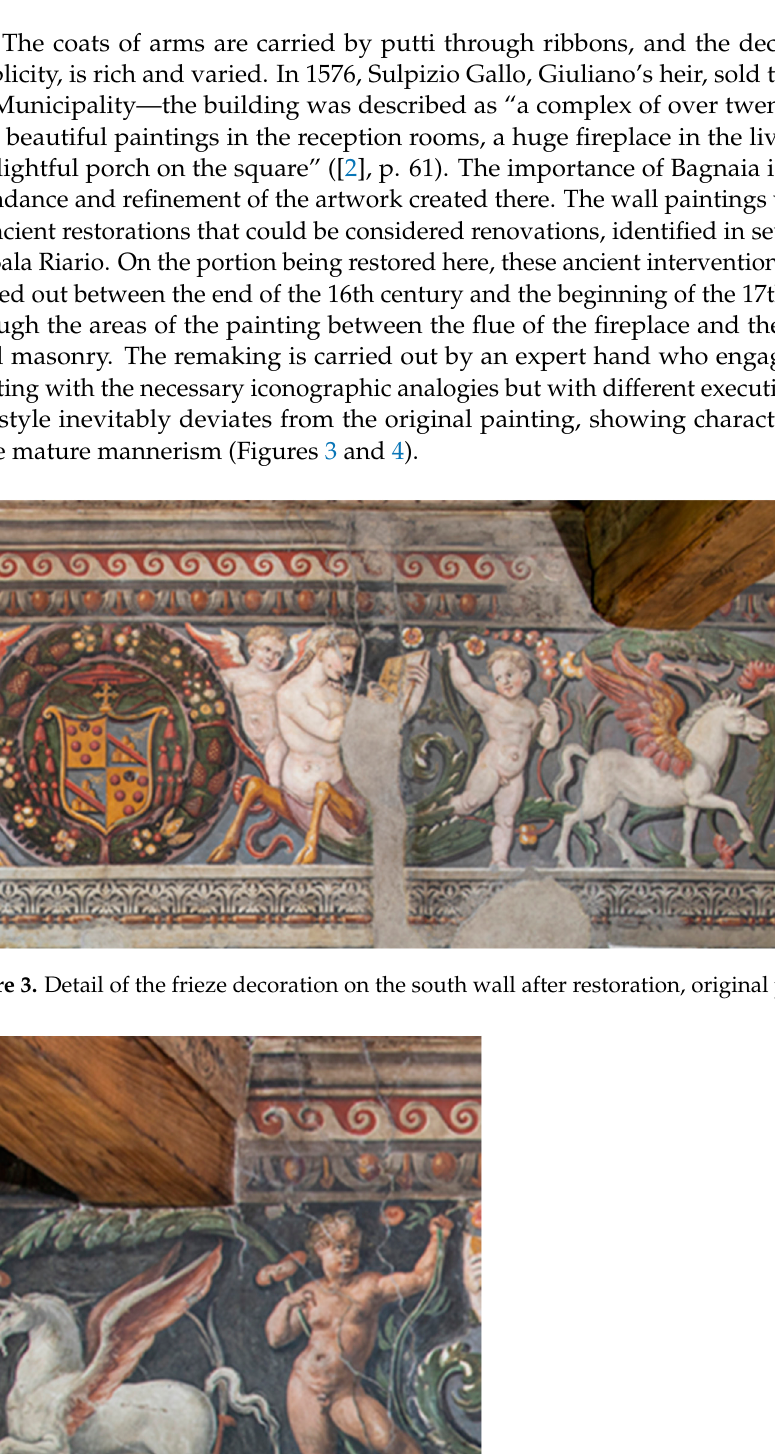
Figure 2. Ceiling of the Sala de Rossi, adjacent to that of Sala Riario.